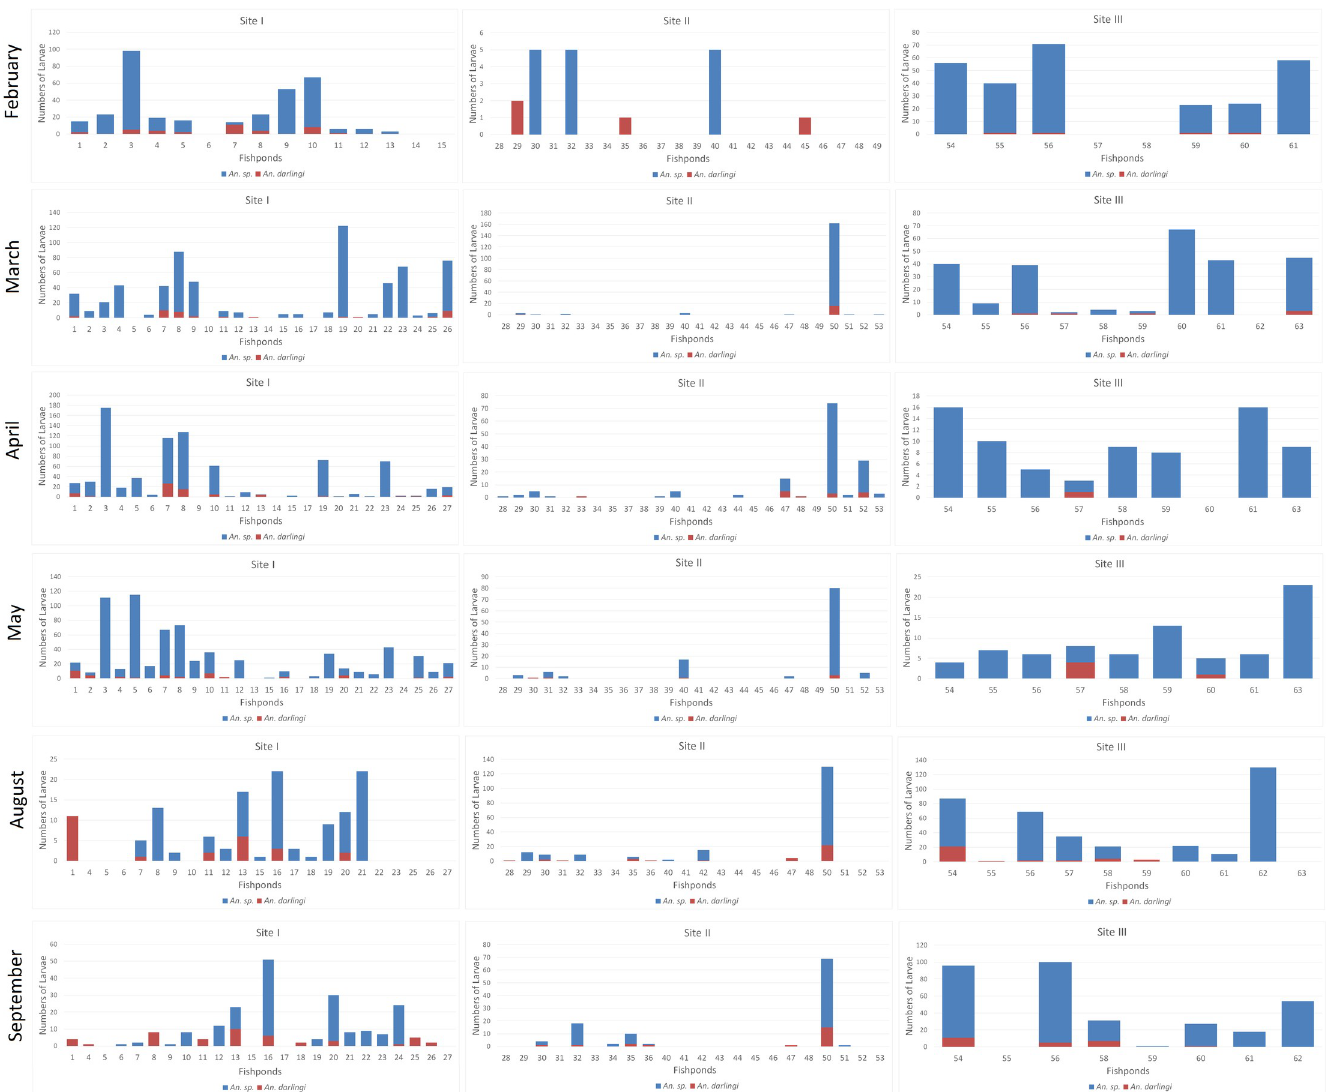
Fig 3. Summary of larvae collected in the study. Anophelinae spp. and Ny . darlingi (both L2 to L4 stages), distributed by fishpond, site and